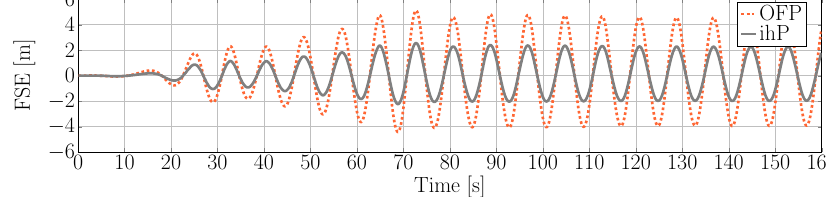
Figure A6. Free surface elevation (FSE) time trace from simulations with a NB with length 2 λ and damping factor S = 10 at the centre location of the CNWT extracted with the OFWP (dashed line) and ihWP (solid line).